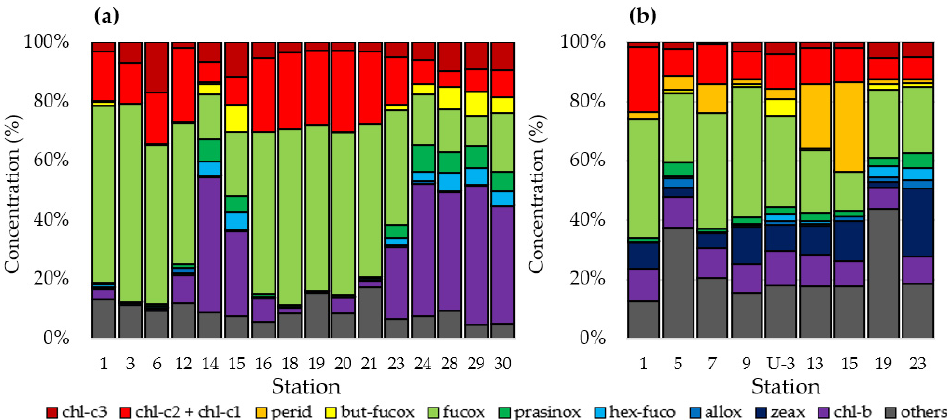
Figure 5. Pigment compositions of total phytoplankton in the ( a ) ARA07B ( b ) OSO040. Based on the CHEMTAX results, eight major phytoplankton communities were identi- fied in the study area (Figure 6). Diatoms (43.1% ± 31.5%) and Phaeocystis (33.2% ± 14.9%) were co-dominated during the ARA07B. In comparison, Diatoms were the most dominant community (46.1 ± 17.3%) and the second dominant community was Prasinophyte (Type 2) (11.8% ± 5.3%) for the OS040. Micro-phytoplankton communities were most dominant (59.7 ± 30.5%), followed by nano-phytoplankton (11.5 ± 9.7%) and pico-phytoplankton (28.9 ± 23.5%) during the ARA07B. For the OS040, micro-phytoplankton contributed 51.5% ( ± 18.2%) of the total chlorophyll a concentration. In comparison, nano-phytoplankton and pico-phytoplankton contributed 11.0% ( ± 10.5%) and 37.5% ( ± 15.7%), respectively. The relative proportions of the three size classes based on the diagnostic pigments from HPLC are different from those of the size-fractionated chlorophyll- a concentrations (Figure 4). This is probably due to a simple assumption that diatom-related pigments belong to the micro-phytoplankton although small diatoms (<2 µ m) could contribute to the phytoplankton group.